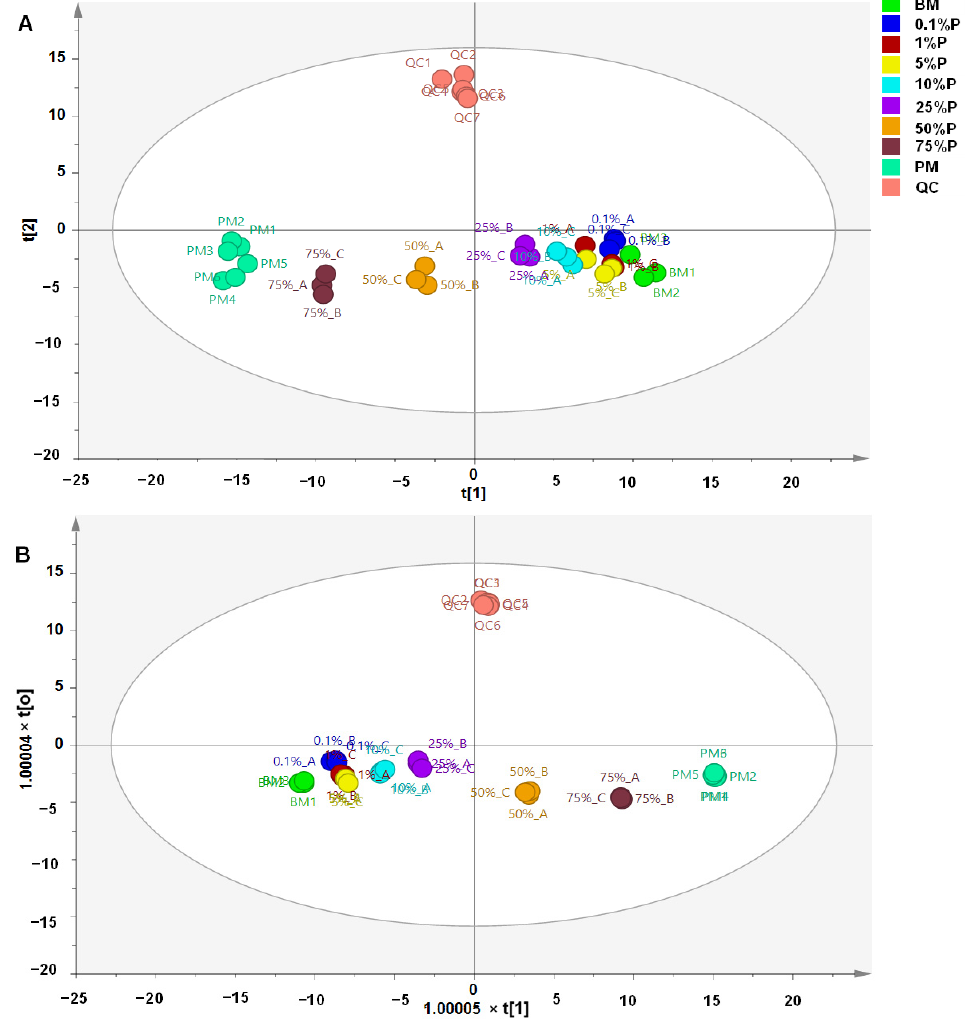
Figure 3. Partial least square ‐ discriminant analysis ( A ) and orthogonal projection to latent structures ‐ discriminant analysis ( B ) for discrimination and classification of meatballs made from beef, pork, and a mixture of beef ‐ pork (BM = beef meatballs; PM = pork meatballs; the percentage indicates the percentage of pork added in beef meatballs).